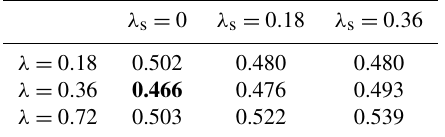
Table 2. Results (misfit J ) of sensitivity experiments with model RetroMOPS, regarding parameters λ s and λ for DOP decay rate. The misfit of the reference scenario RetroMOPS r is indicated in bold. λ s = 0 λ s = 0 . 18 λ s = 0 .